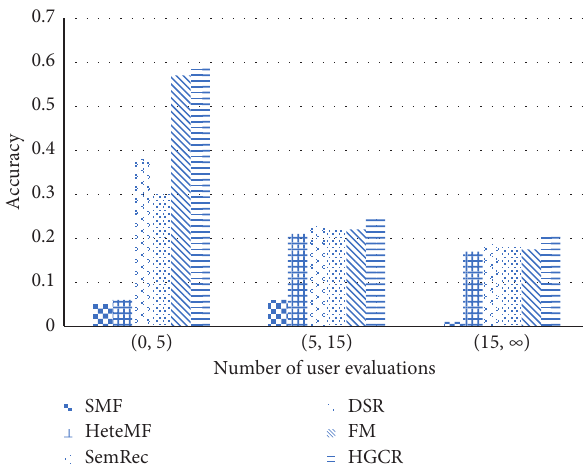
Figure 7: Performance of cold start on Douban Book.